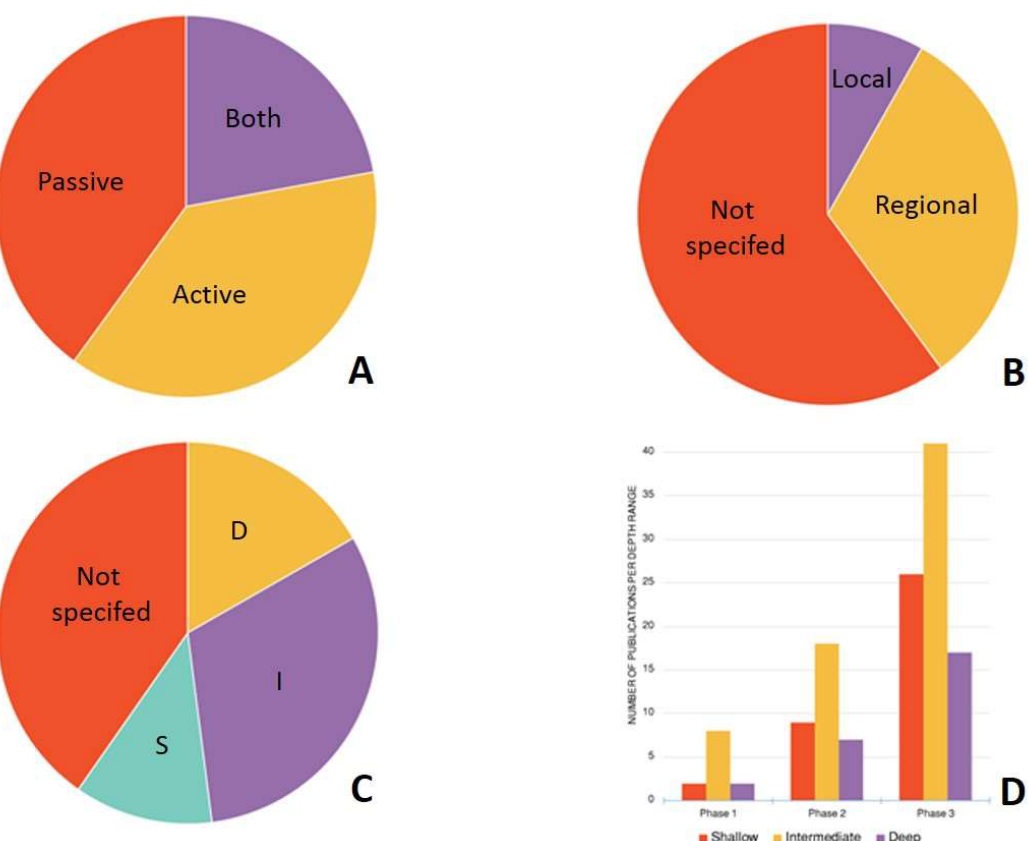
Figure 6. Qualitative and quantitative results of the spatio-temporal parameters. ( A ): Records of publications on different types of continental margins; ( B ): Records of publications on regional and local geographic scales; ( C ): Records of publications on shallow, intermediate, and deep waters; ( D ): Number of articles per depth range during three phases over the 35-year period analyzed.